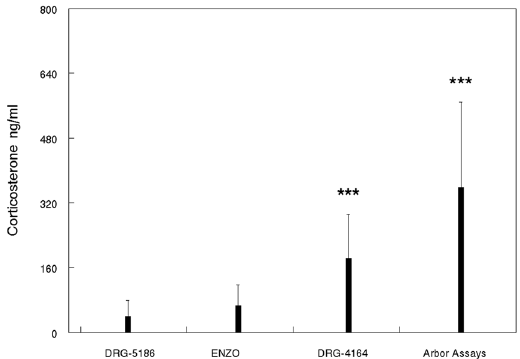
Figure 1. Corticosterone (ng/ml) measured in the four ELISA assays. Bars and whiskers indicate mean +